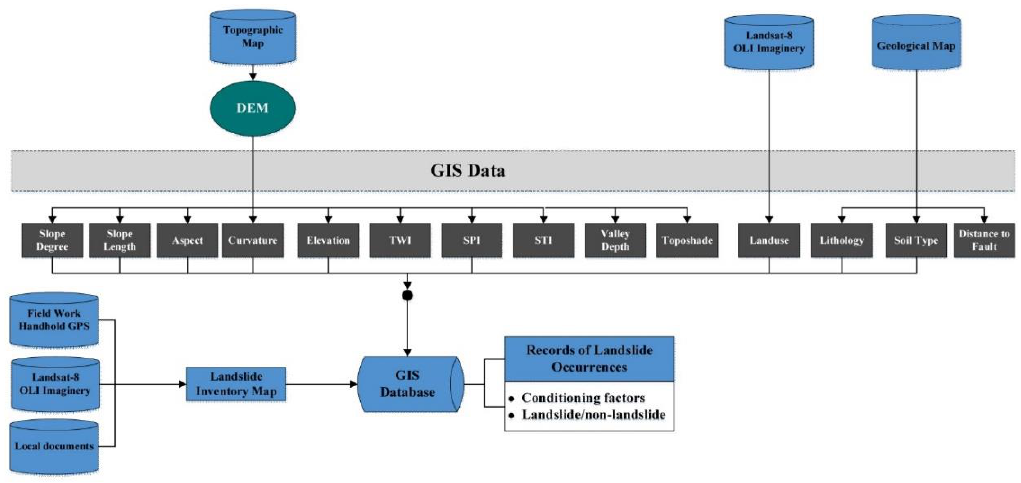
Figure 7. The established GIS database.